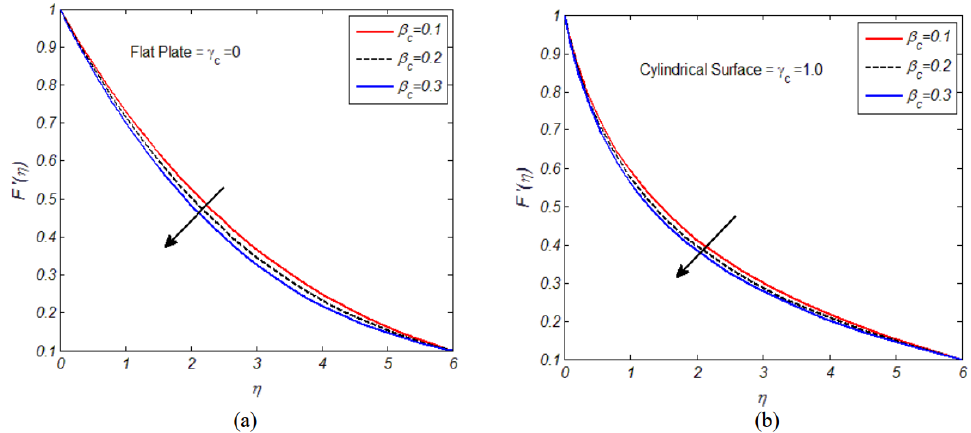
 on velocity at cylindrical